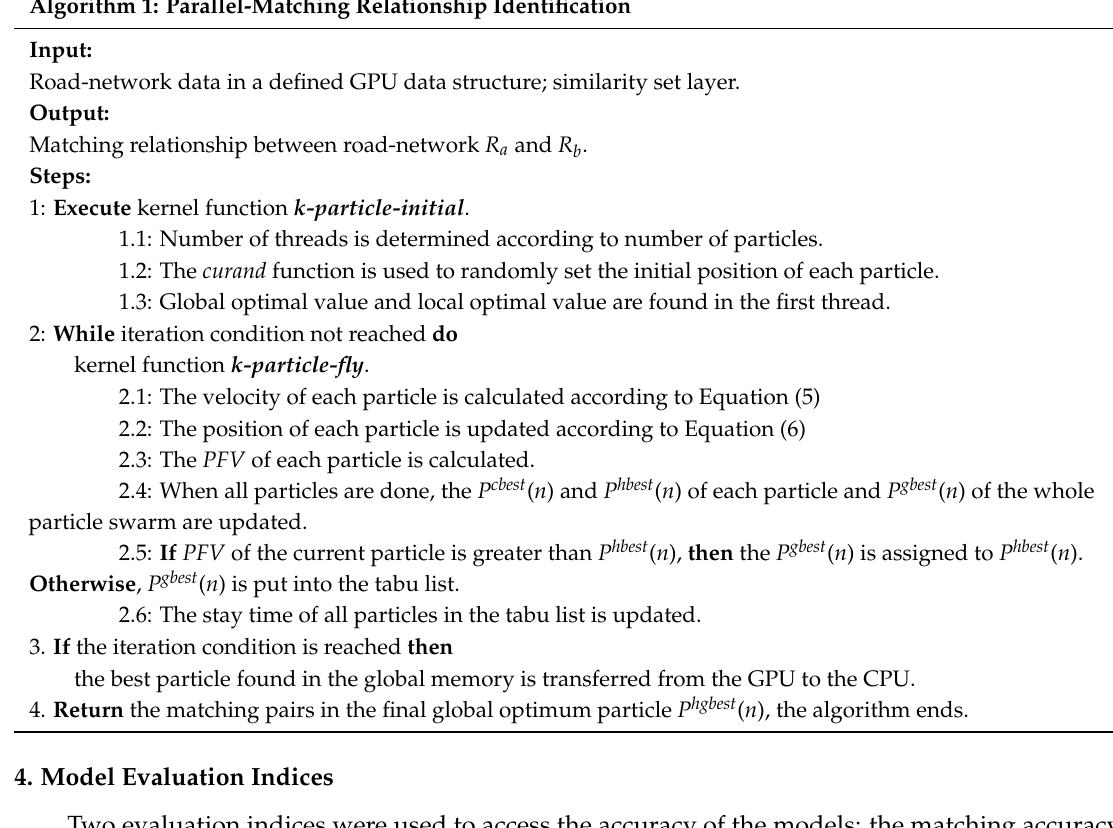
Algorithm 1: Parallel-Matching Relationship